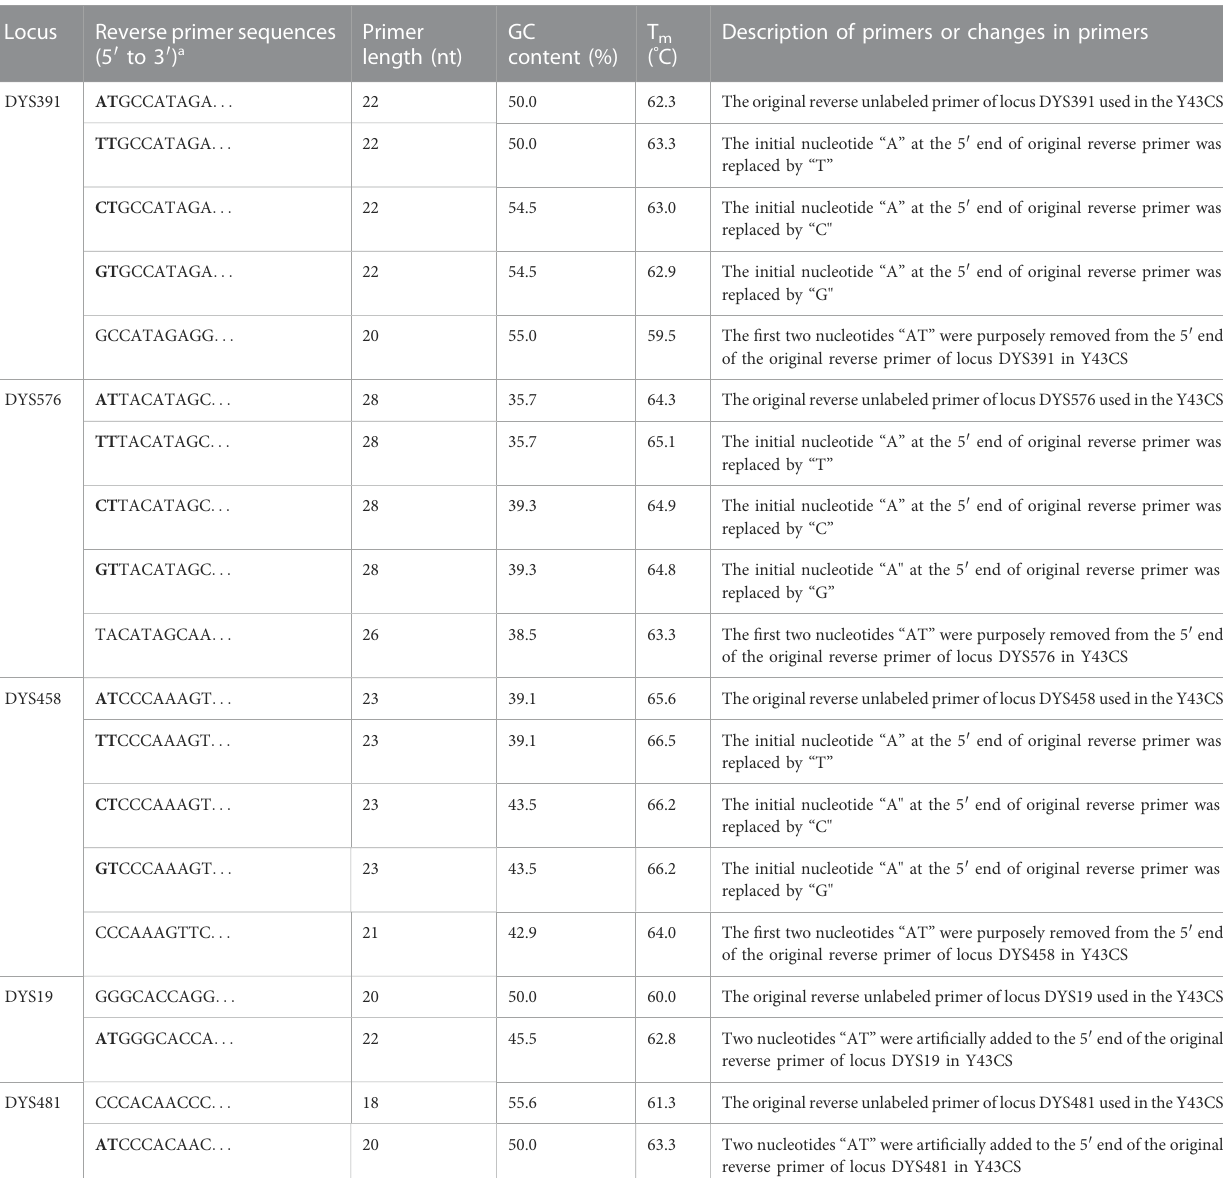
Primer GC T m Description of primers or changes in primers length (nt) content (%) ( ° C)